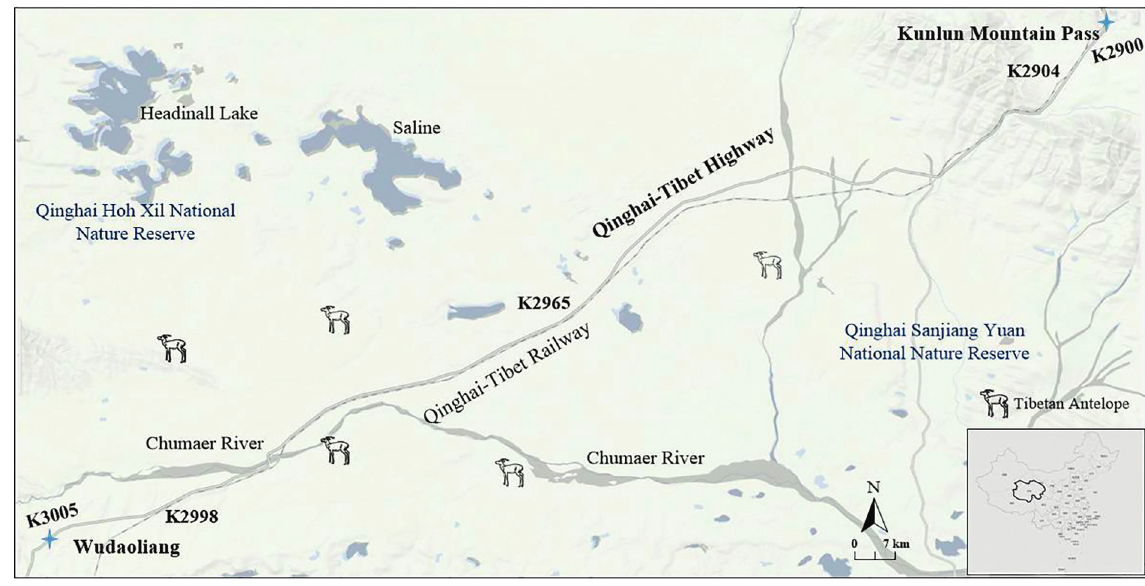
Figure 1: Map of the survey